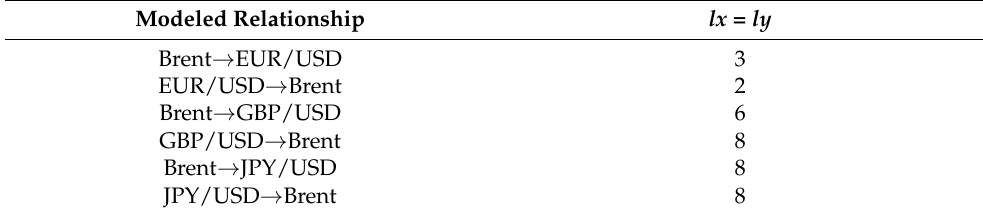
Table 5. Lag lengths in the constructed SVR models. Modeled Relationship lx = ly Brent →